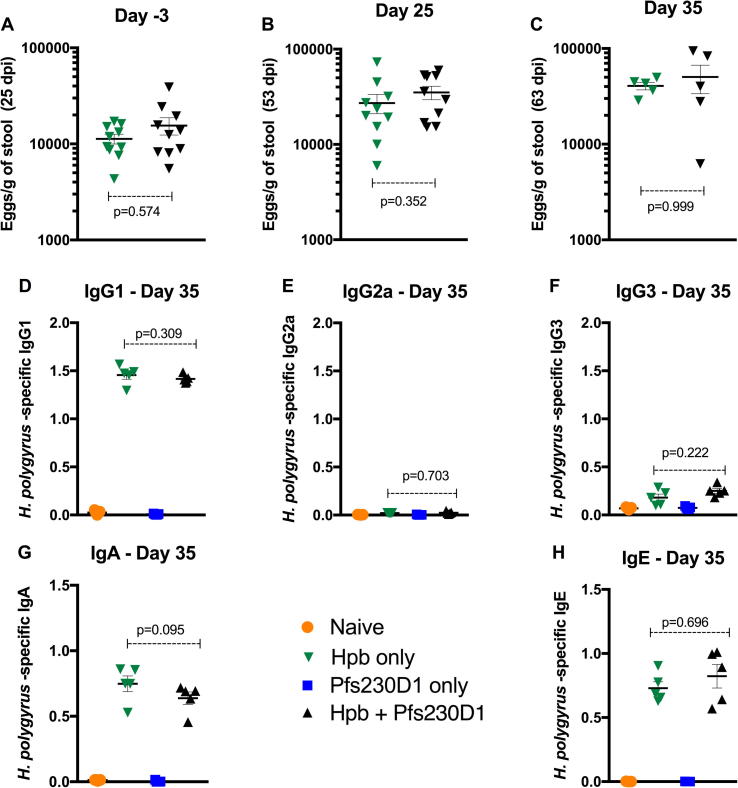
Hpb Infection pattern was sustained after immunization. (a) Amount of Hpb eggs were similar in stools collected in animals infected only or both infected/vaccinated at days −3 (p = 0.574), 25 (p = 0.841) and 35 (p = 0.999). (b) ELISA optical density in response to Hpb antigen in sera. Sera collected at days −1, 15, 25 and 35 were used to assess IgG1, IgG2a, IgG3, IgE and IgA responses to H. polygyrus bakeri. Data are shown as mean + SEM.